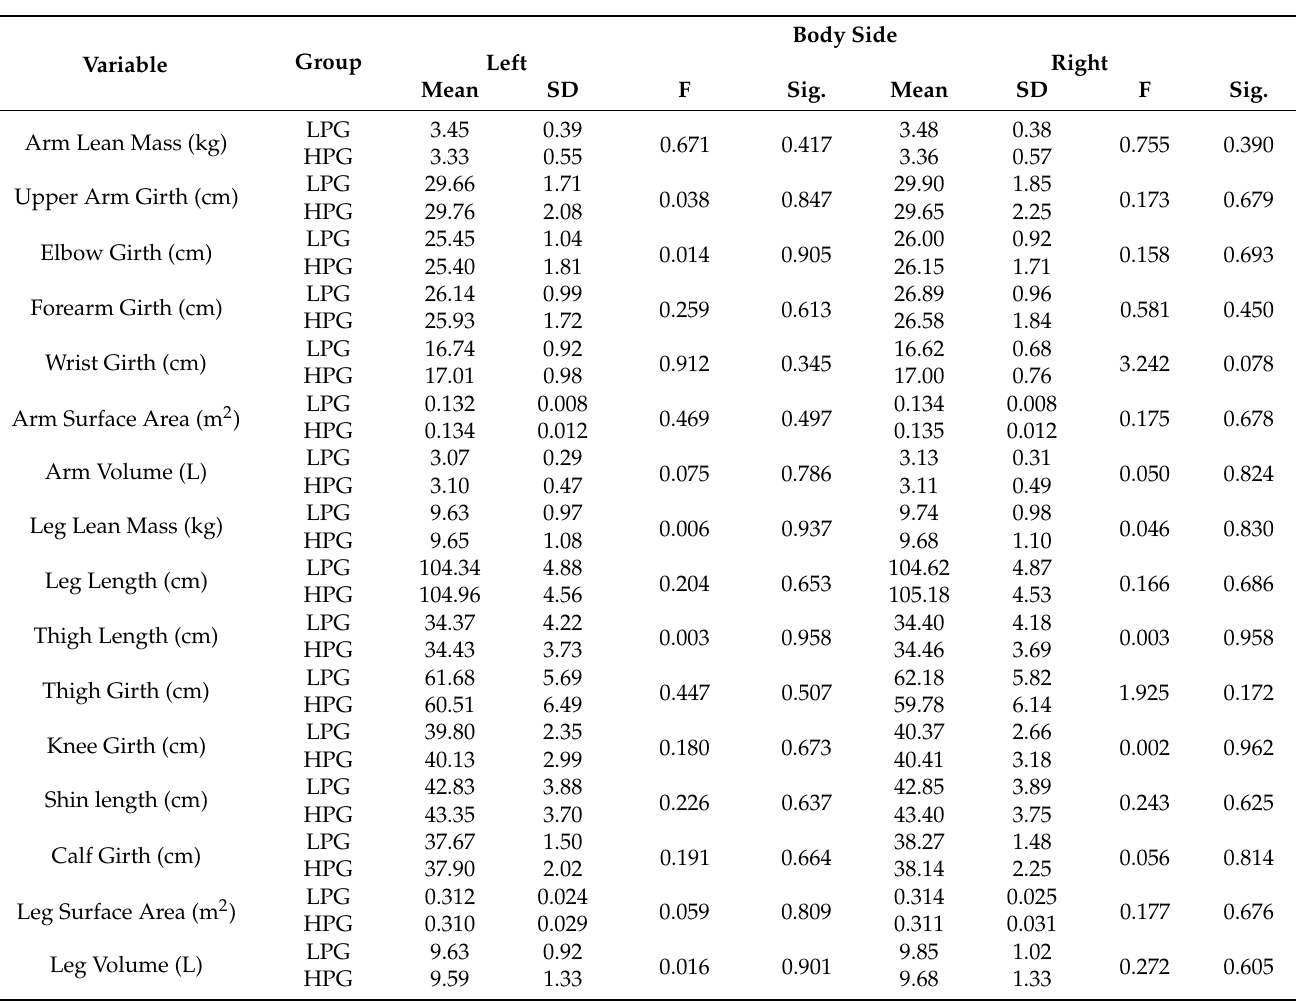
Table 4. One-way ANOVA with the descriptive presentation of the morphological variables between the LPG and HPG for the left and right body